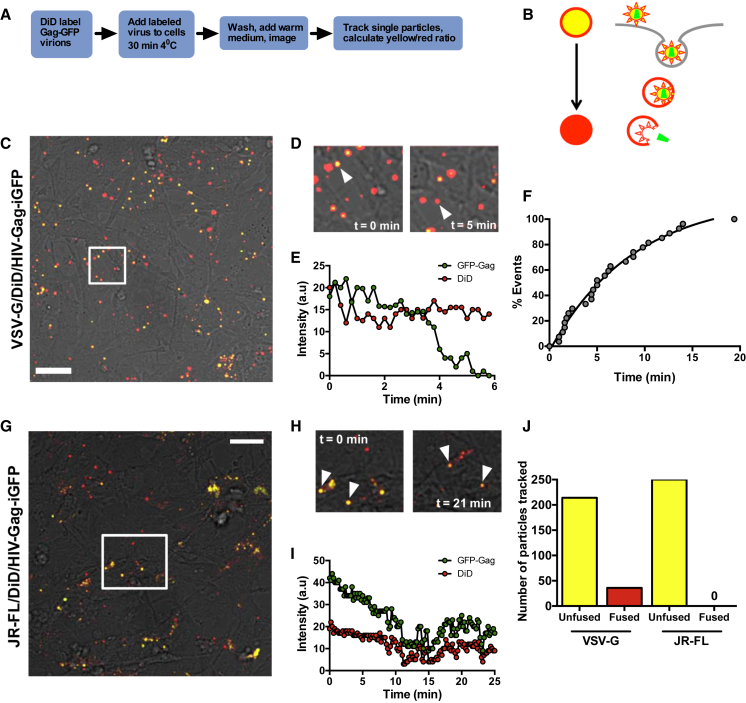
Single-Particle Tracking Fails to Reveal HIV-1 Env Fusion with HFAs(A) Experimental plan.(B) Cartoon of entry assay events. Yellow double-labeled (DiD, red; GFP, green) virions enter the cell by endocytosis. Fusion results in the red label entering the endosomal membrane and the green signal moving into the cytosol away from the plane of focus, leaving a red vesicular signal.(C) Low-magnification x-y CM image of single- and double-labeled HIV-1-VSV-G particles on HFAs at T = 0. Arrowhead points to the double-labeled virion that fuses in (D). Scale bar, 10 μm.(D) Close-up of white boxed area in (B) at T = 0 (left panel) and T = 5 min (right panel). Arrowheads point to the virion (yellow in the left panel) and the fusion event (red in the right panel). Region of interest represents 10 × 10 μm. See Movie S1.(E) Data from the fusion event tracked in (C), in which the signal for the green channel is lost between 3.5 and 5 min while the red channel signal remains constant.(F) Kinetic distribution of 28 single fusion events from four independent experiments.(G) Low-magnification image of single- and double-labeled HIV-1-JRFL particles on HFAs at T = 0. Scale bar, 10 μm.(H) Close-up of white boxed area in (G) at T = 0 (left panel) and T = 21 min (right panel). Arrowheads indicate double-labeled yellow virions. Region of interest is 15 × 12 μm. See Movie S2.(I) Data quantified from a virion tracked in (H) in which the signal for red and green channels remains constant after initial photobleaching of the green signal between 0 and 10 min.(J) Summary of fusion events totaling ∼17% of all tracked yellow double-labeled particles (36 of 250) for VSV-G and 0% (0 of 250) for JR-FL. Data presented are from ten independent experiments using three MDM donors. See Figure S3 and Movies S3 and S4 for fusion data in MDMs.